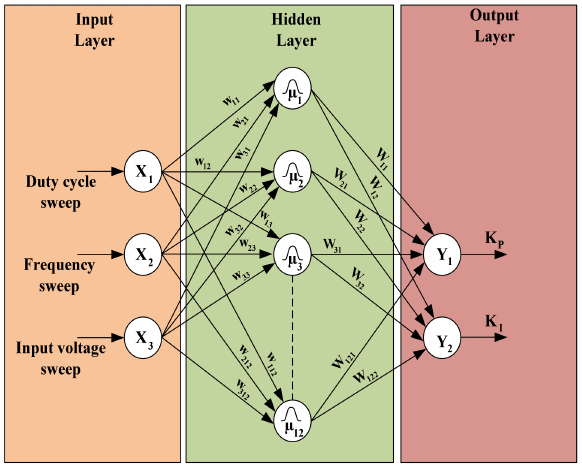
Figure 10. Layers and weighted connection of proposed